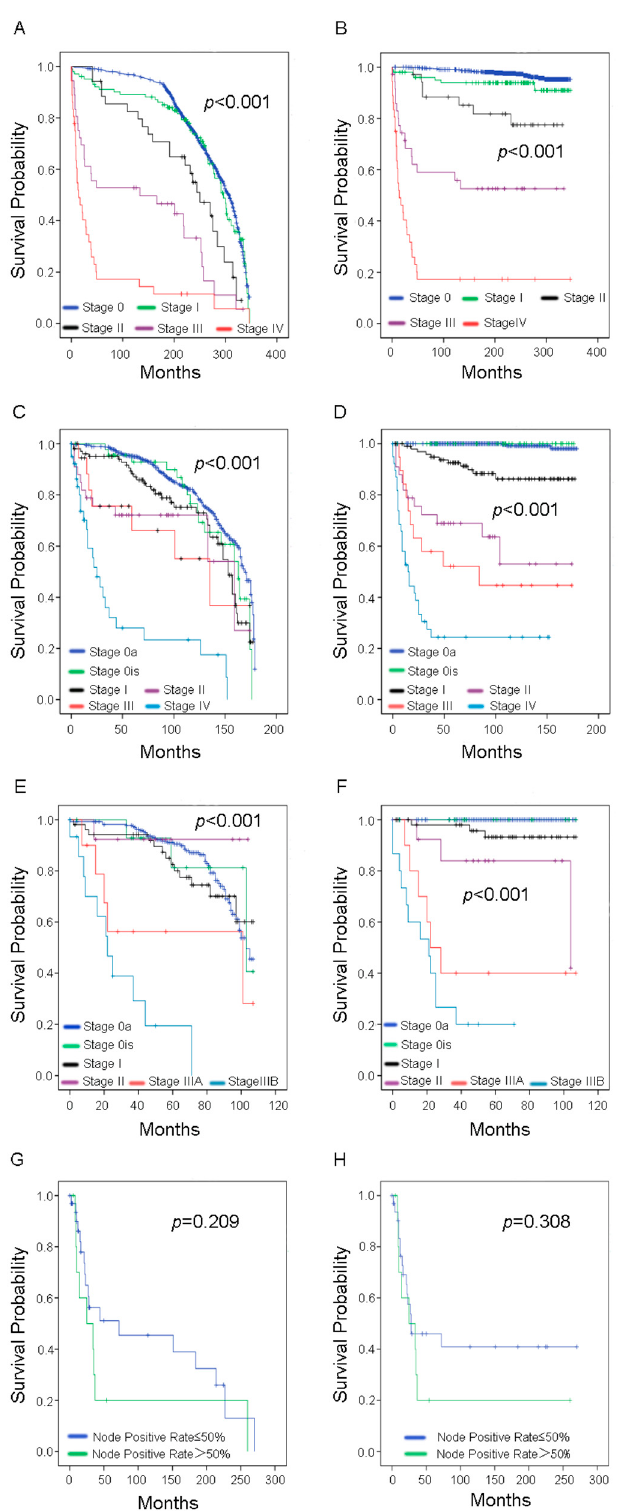
Figure 4. Survival analysis in younger bladder cancer patients with AJCC cancer stage based on each edition of the AJCC Manual ( A , B ) AJCC Manual 3rd edition; ( C , D ) AJCC Manual 6th edition; ( E , F ) AJCC Manual 7th edition) and node-positive rate (positive/examined) ( G , H ). Left column: overall survival; right column: cancer-specific survival.